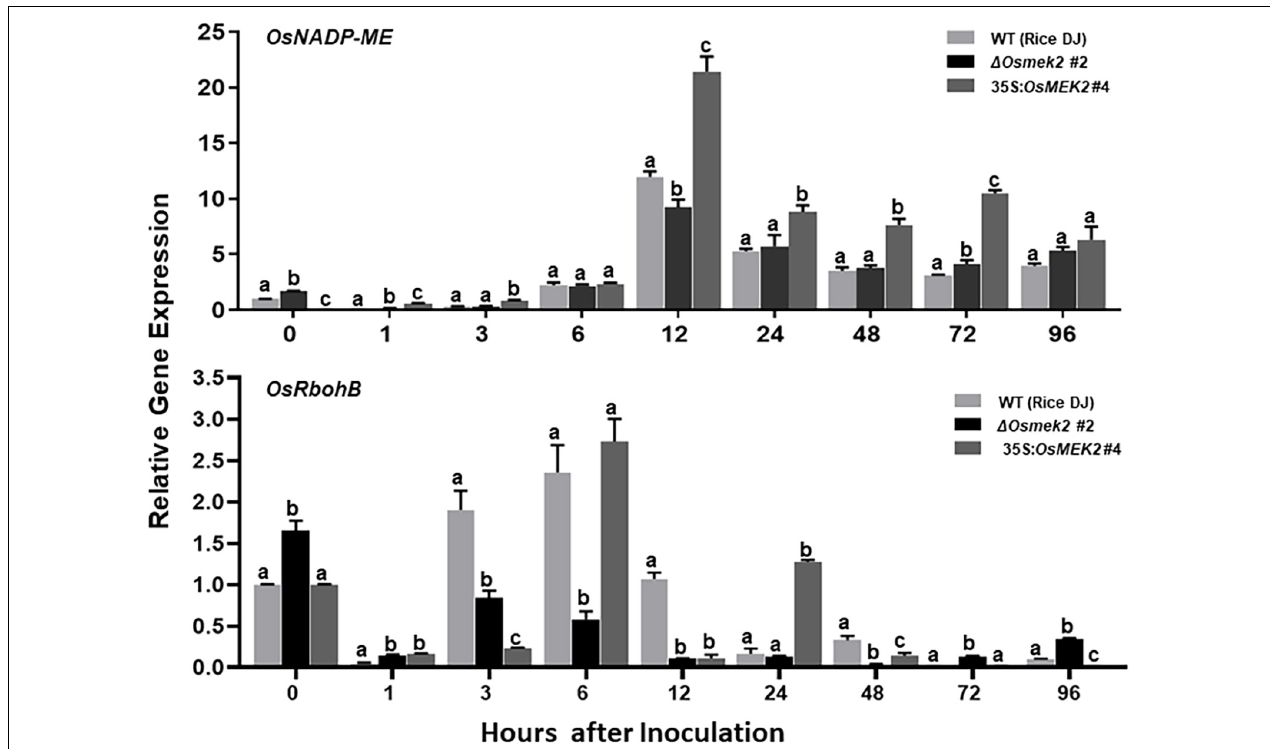
FIGURE 10 | Quantitative real-time RT-PCR analysis of time-course expression of OsNADP-ME and OsRbohB in rice leaf sheaths infected with avirulent Magnaporthe oryzae 007. Leaf sheaths of the wild-type (WT) rice cultivar DJ, OsMEK2 knock-out ( (cid:49) Osmek2 #2) and OsMEK2- overexpressed (35: OsMEK2 #4 ) plants were sampled at different time points after inoculation, followed by total RNA extraction. Relative gene expression levels of OsNADP-ME (Os01g52500) and OsRbohB (Os01g25820) at each time point were calculated by normalizing with respect to the expression of the internal control 18S rRNA (XR_003238819.1) gene. Data represent the means ± SD from three independent experiments. Different letters above the bars indicate significantly different means ( P < 0.05), as analyzed by Fisher’s protected LSD test.